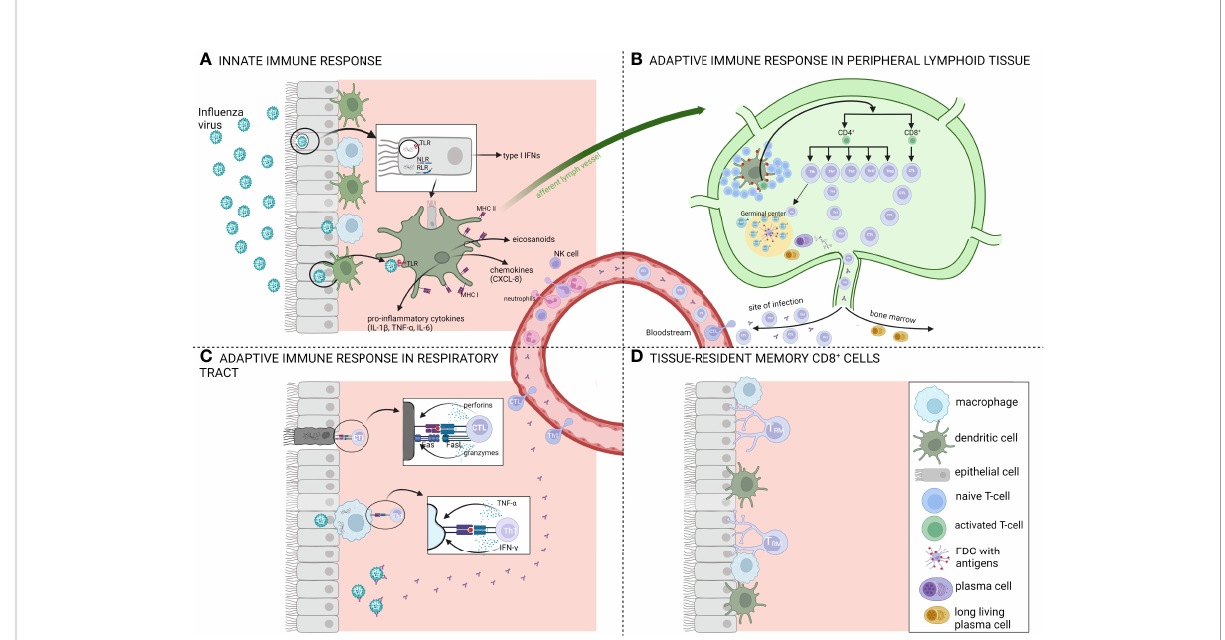
FIGURE 2 Schematic overview of the immune response after in fl uenza infection. (A) Overview of the innate immune response which forms a fi rst-line barrier in the mucosal surfaces. Viral RNA recognition by several pattern recognition receptors (PRR) like toll-like receptors (TLR), Nod-like receptors (NLR) and RIG-I-like receptors (RLR) leads to the secretion of type I interferons (IFNs) and pro-in fl ammatory cytokines such as IL-1 b , TNF- a and IL-6. Antigen presenting cells (APCs) capture the antigens and migrate via the afferent lymph vessels to draining lymph nodes where they present the antigens to T-and B-lymphocytes. (B) Overview of the adaptive immune response in peripheral lymphoid tissue. T-and B- lymphocytes undergo a stepwise process of activation, proliferation and differentiation. In fl uenza infections typically induce a Th1-biased immune response. After activation, CD4 + and CD8 + T-cells migrate to the site of infection while long-lived plasma cells migrate to the bone marrow. (C) Overview of the adaptive immune response in the respiratory tract. Here, CD8 + T-cells or cytotoxic T-lymphocytes (CTLs) contribute to viral clearance by direct lysis of the infected cells via perforins and granzymes or via a Fas-dependent processes. (D) The respiratory tract once the infection is cleared, 90% to 95% of the in fl uenza-speci fi c T-cells undergo apoptosis and the remaining cells are destined to become long-lived tissue-resident memory T-cells (Trm). Figure created with